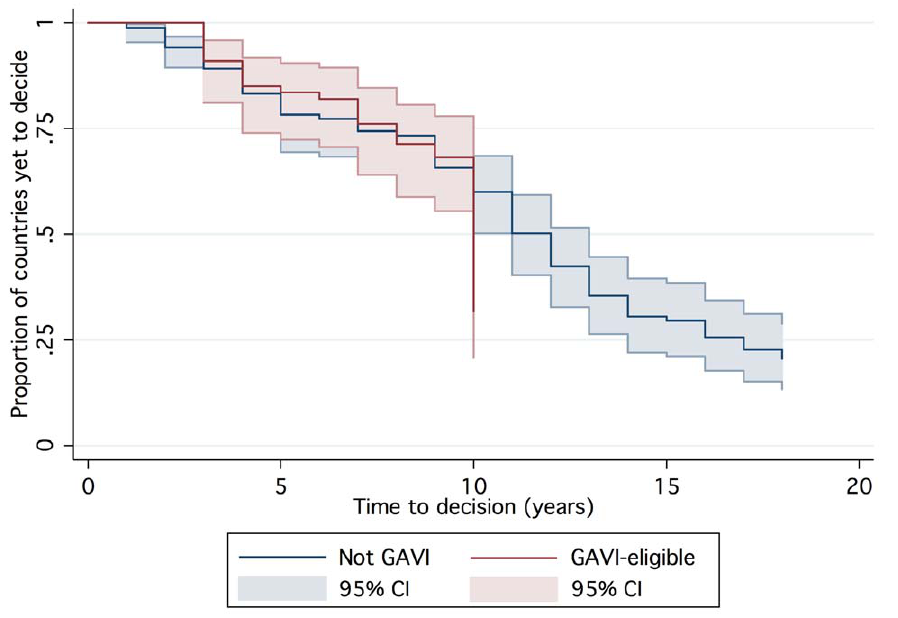
Figure 1. Time to decision by GAVI and non-GAVI countries. Time=0 represents first availability (licensure) of Hib vaccine (1998 for UNICEF procurers; 1990 for others).